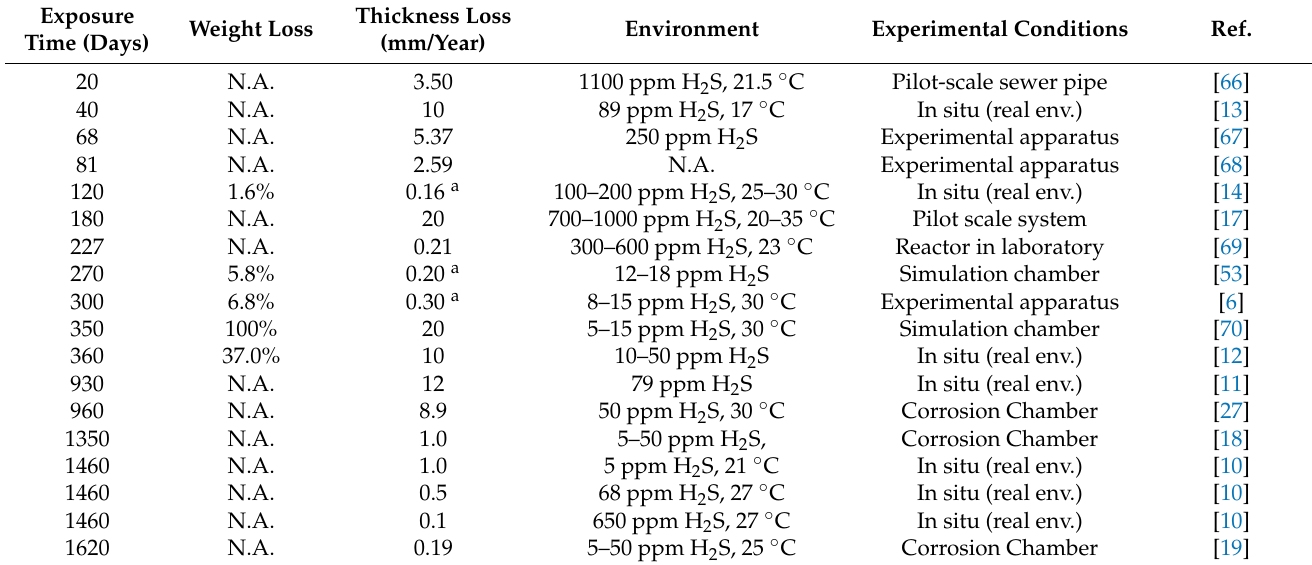
Table 1. Concrete losses produced by biodeterioration according to the